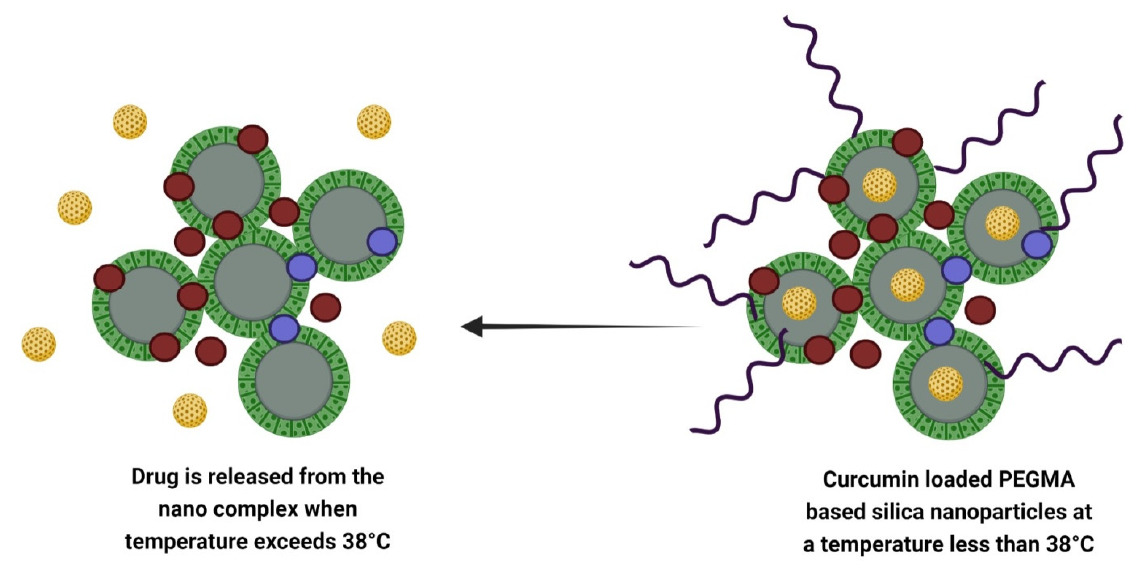
Figure 3. Design of curcumin-loaded temperature controlled dual imaging drug carrier system.